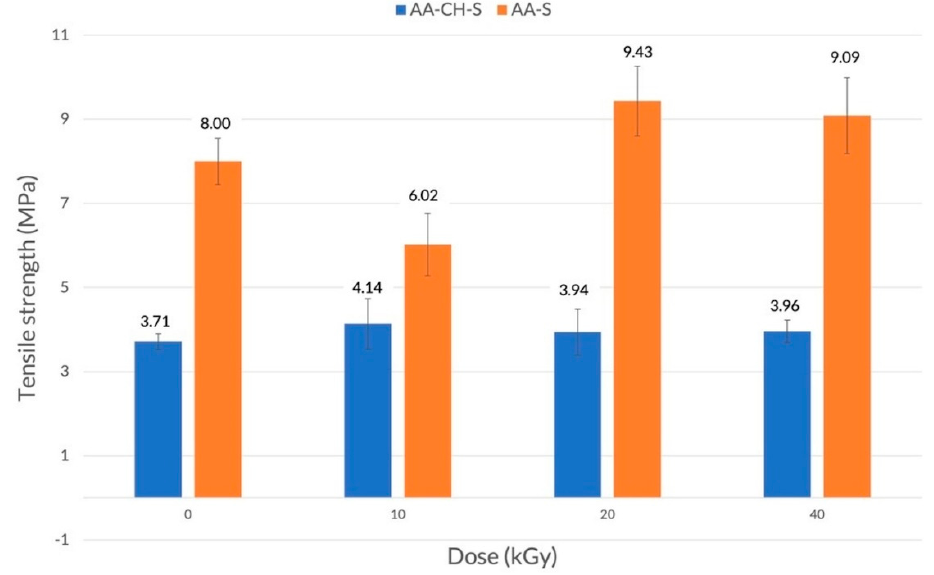
Figure 1. Tensile strength of AA-CH-S (blue) and AA-S (orange) films irradiated with doses of 10, 20, and 40 kGy in the machine direction.